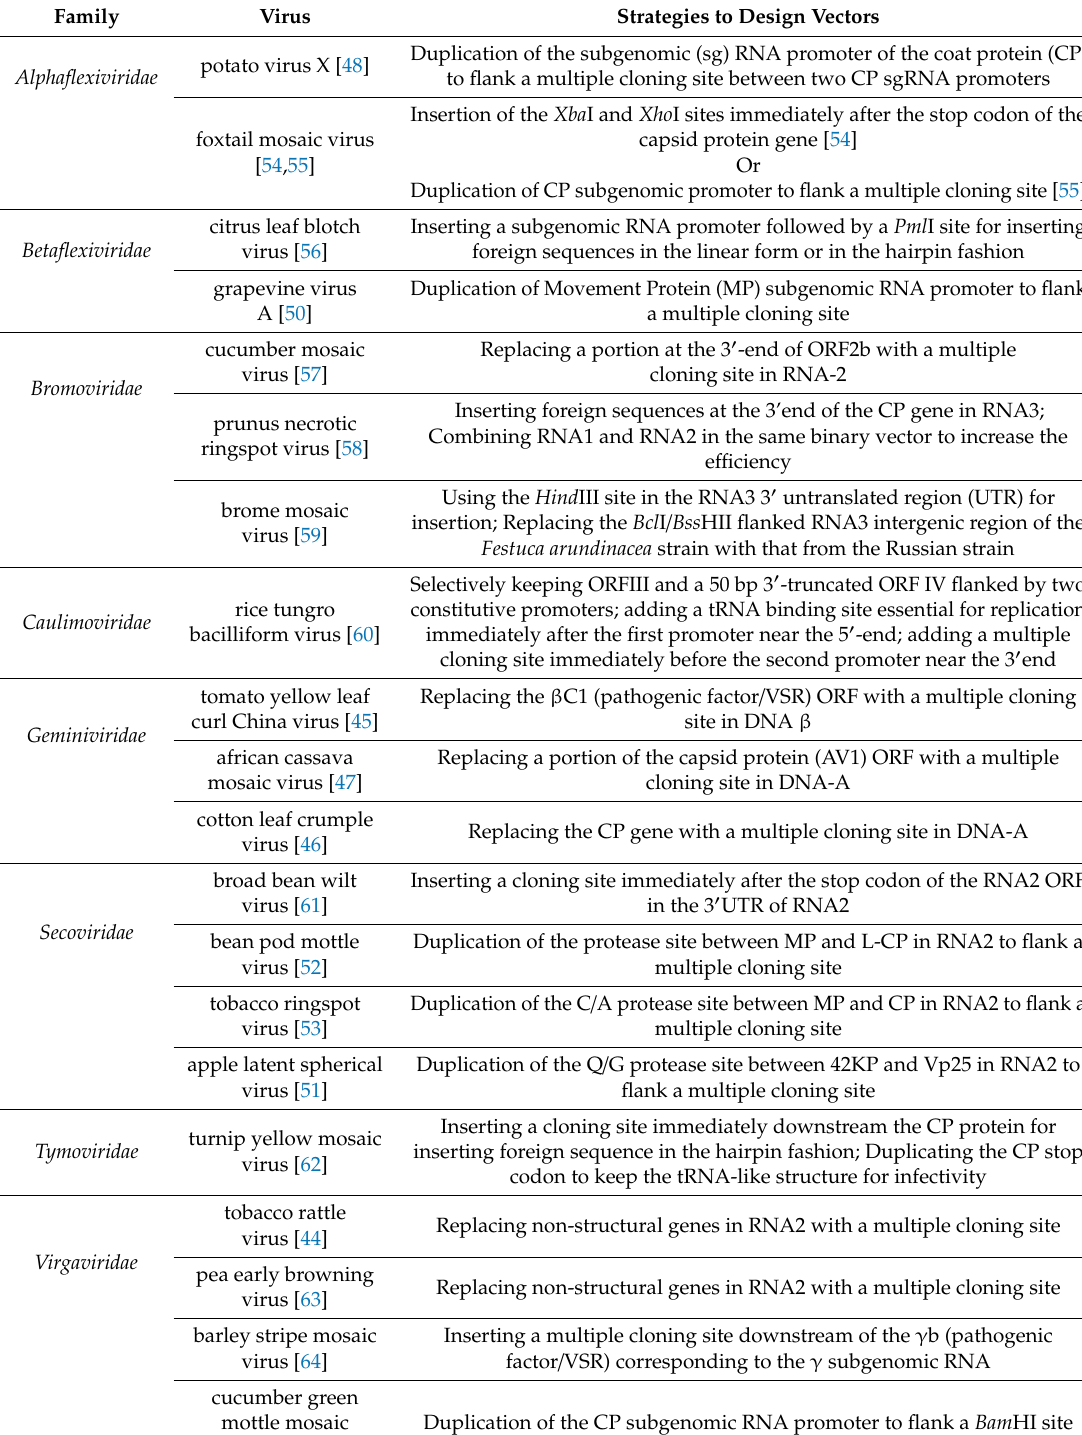
Table 1. Strategies to engineer VIGS vectors for major